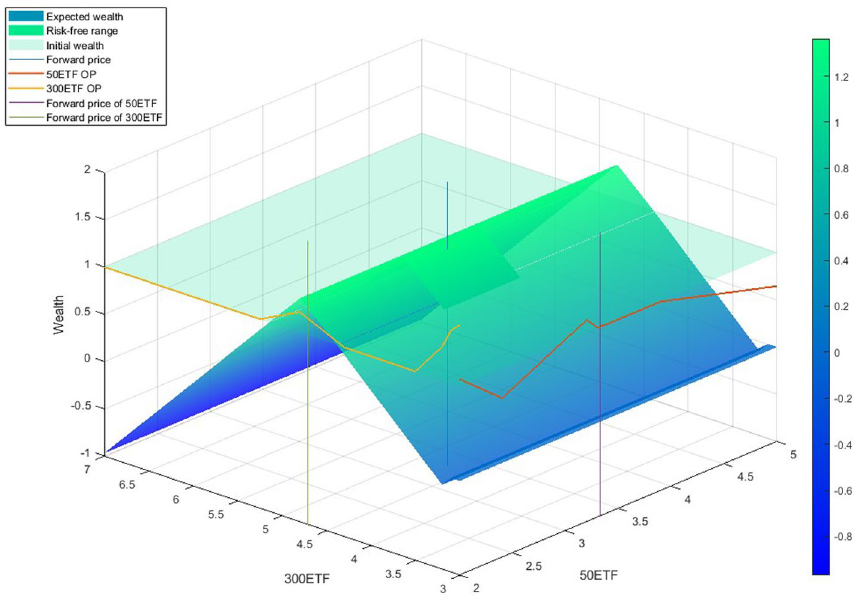
Fig. 9 The relationship between underlying asset prices and expected wealth of the risk-free model. Note: This graph depicts the effect of forward price changes on the expected wealth of the risk-free model. The curved surface is the expected wealth value of the multi-asset risk-free model. The dark green surface is the risk-free range of the model. The light green color indicates the initial wealth for comparison purposes. The orange and yellow lines are the expected wealth of the 50 ETF and 300 ETF option portfolios, respectively. The vertical line indicates the price of the underlying asset at the final exercise. The blue line then shows